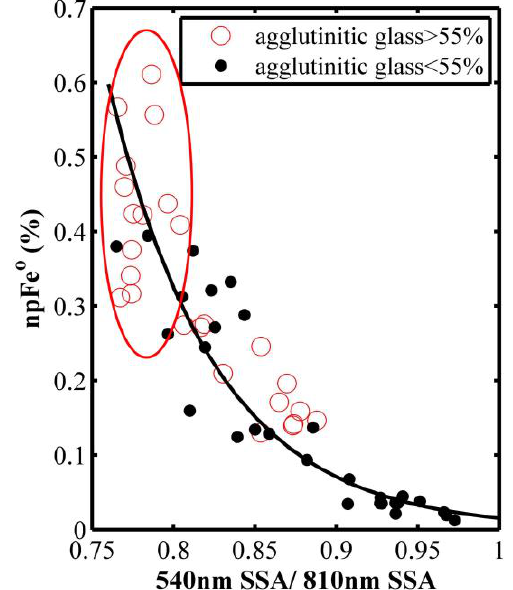
Figure 10. Correlation between the ratio of 540 nm SSA/810 nm SSA and npFe 0 denoted by different groups of LSCC lunar samples with varying agglutinitic glass content. Solid black line is the regression line defined in Figure 4.